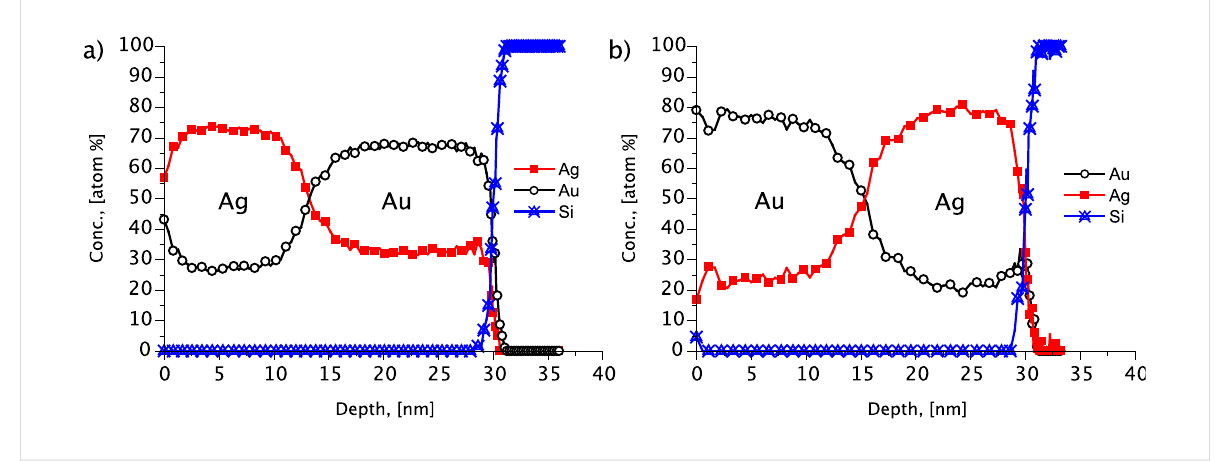
Figure 6: Depth profiles of Ag(15 nm)/Au(15 nm) (a) and Au(15 nm)/Ag(15 nm) (b) film systems after 20 h at 175